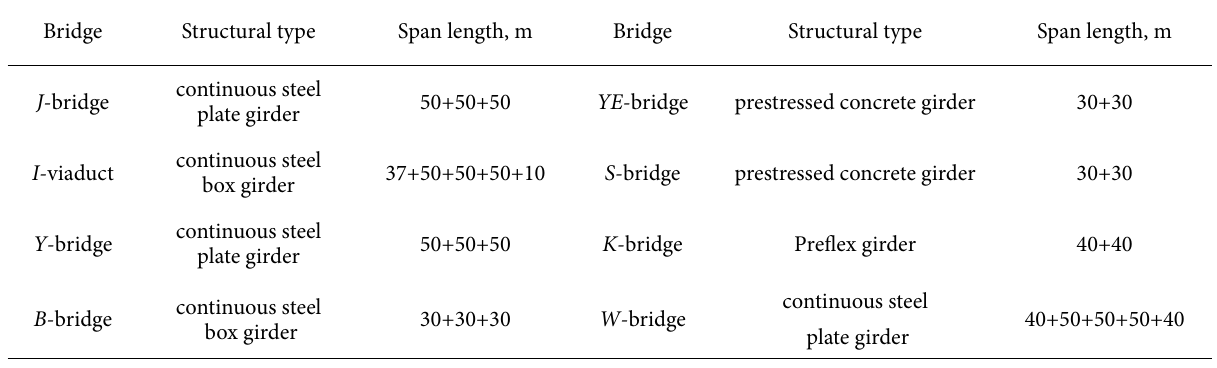
Table 2. Bridges considered for measuring vibrations